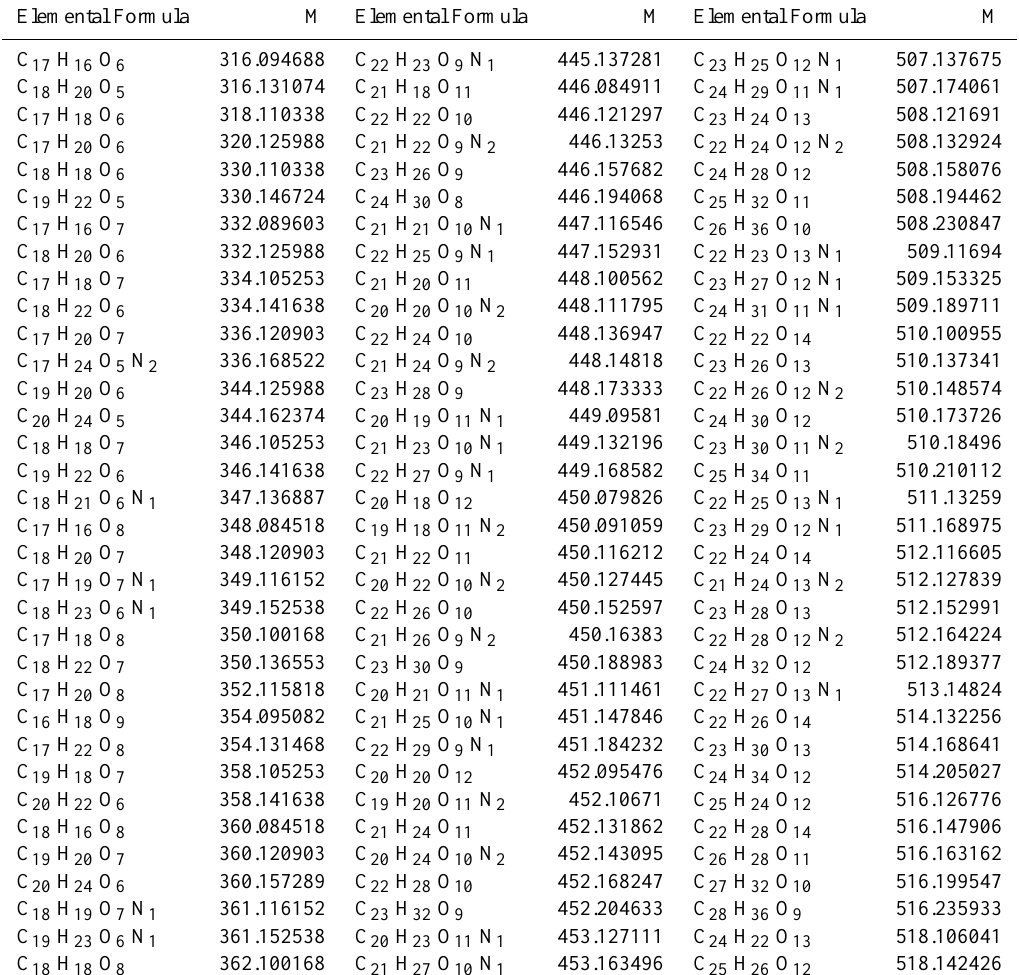
Table A2. NEG molecular formulas: complete list of mass peaks and assigned molecular formulas that showed a highly significant negative correlation ( p < 0 . 01) with SPE-DOM 1 14